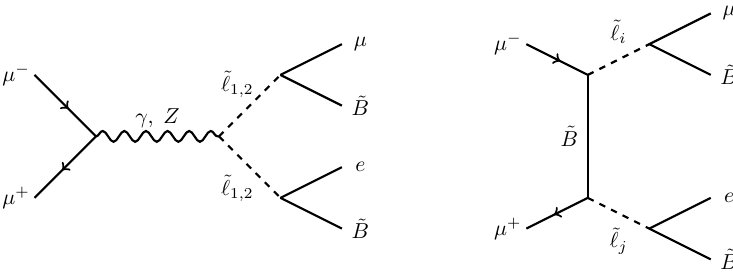
Figure 3. Main production mechanism for the flavor-violating signal at the muon collider.